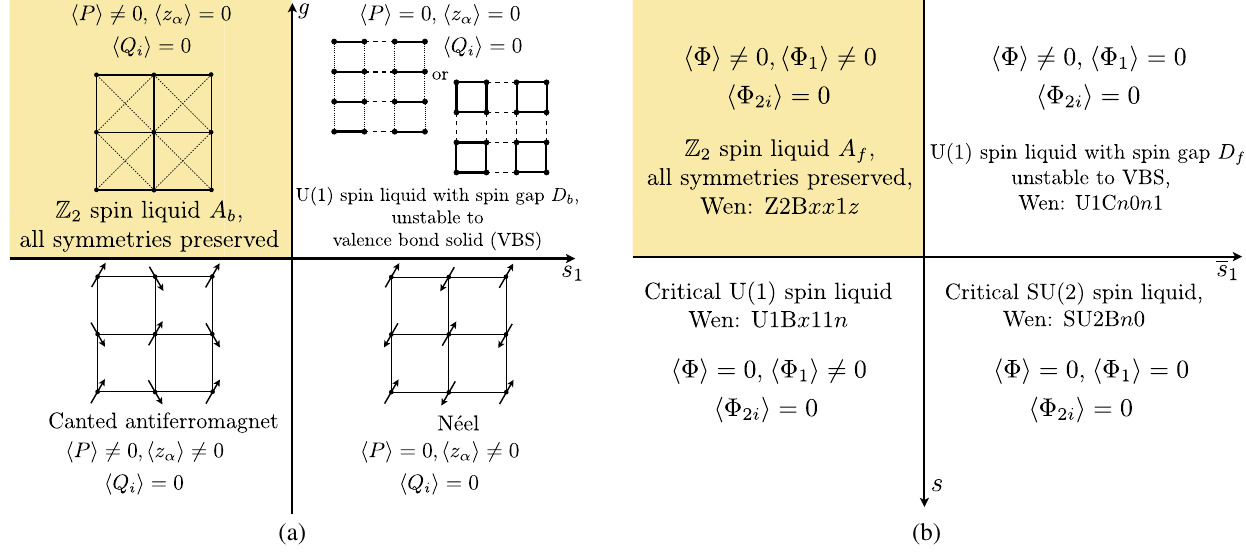
FIG. 1. (a) Schematic phase diagram of the CP 1 theory in Eq. (1.4) as a function of g and s 1 [ s 2 in Eq. (1.7) is large and positive]; Eq. (1.2) describes the deconfined critical N´eel-VBS transition at a critical g ¼ g . (b) Schematic phase diagram of the SU(2) QCD 3 c ¯ s 2 flavors of massless Dirac fermions in Eq. (1.6) as a function of s and ¯ s theory with N 1 [ 2 in Eq. (1.8) is large and positive]. The f ¼ “ Wen ” labels refer to the naming scheme in Ref. [17]. The Z 2 spin liquids A b and A f in (a) and (b) are argued to be topologically identical, as are the confining states with VBS order. The critical spin liquids in (b) are argued to be unstable to the corresponding phases with magnetic order in (a), with the critical SU(2) spin liquid surviving only at the N´eel-VBS transition. All Z 2 spin liquids are shown shaded in all